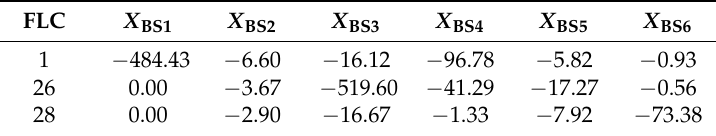
Table 7. Sensitivities with respect to the X